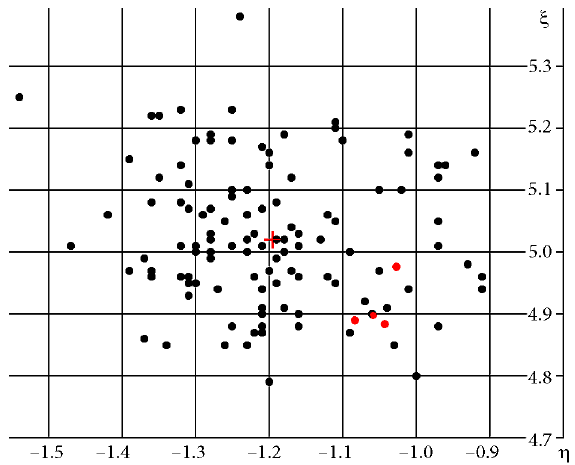
Figure 3. Vertical deflection determination results at the test site within a year. Each point represent averaged result of about 40 minutes long